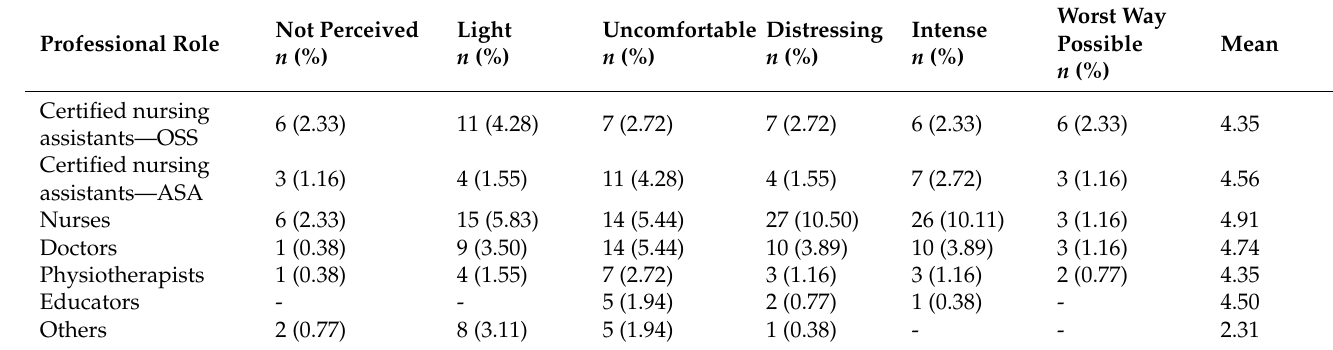
Table 5. Levels of moral distress based on professional role.